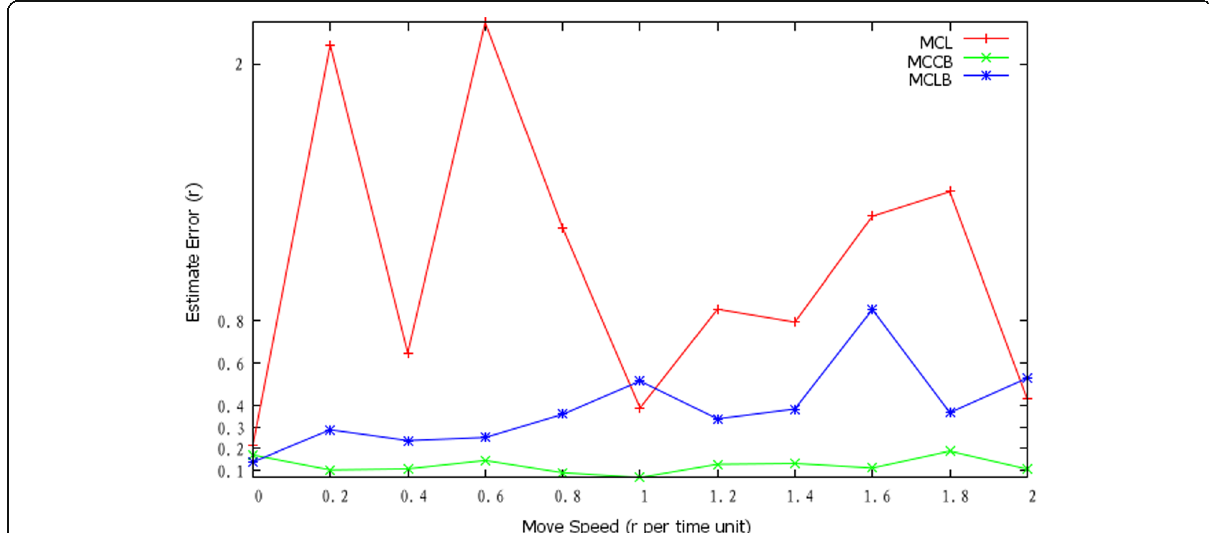
Fig. 9 Roadway width at 10 m comparison chart. For roadway width at 10 m under conditions, MCCB precision accuracy is still the best. It can be seen that the coverage area is much larger than the width of the roadway, and with the roadway width becoming smaller, the positioning accuracy of the positioning method has all the mentioned precision at about 10%. Comparing positioning accuracy under different conditions of the roadway width, the roadway length is fixed at 1000 m; roadway widths are set to 3 m, 5 m, and 10 m; and the anchor node spacing is fixed at 25